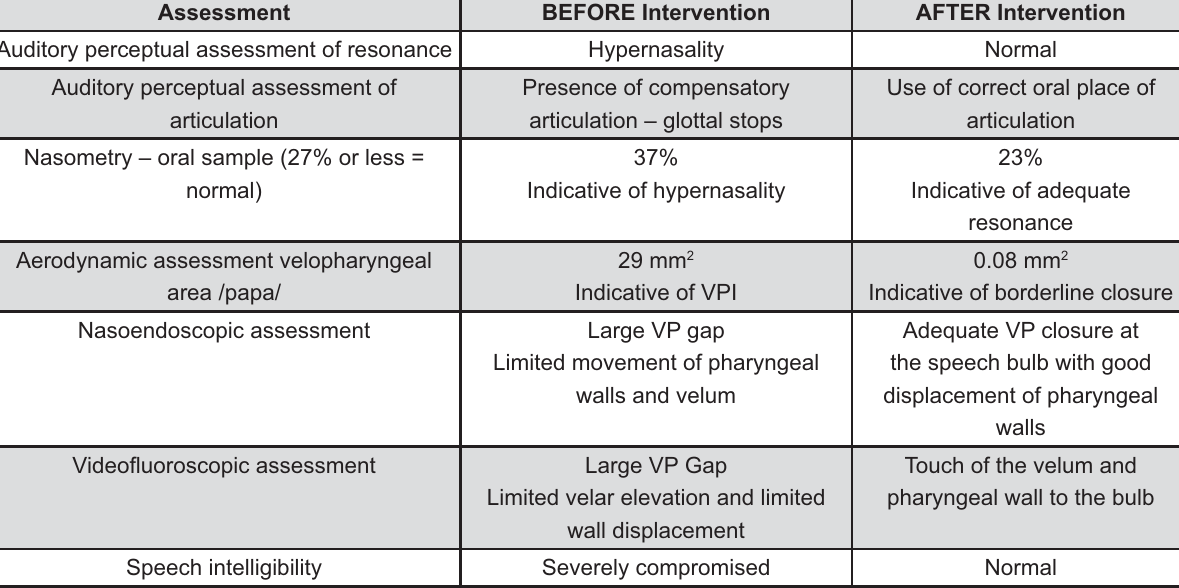
Figure 7- Results of speech and velopharyngeal function assessment before and after intensive therapy and bulb